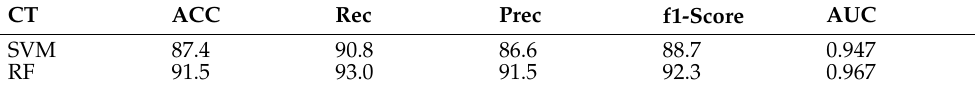
Table 7. Performance scores of SVM and RF for common features for handwritten text dataset.